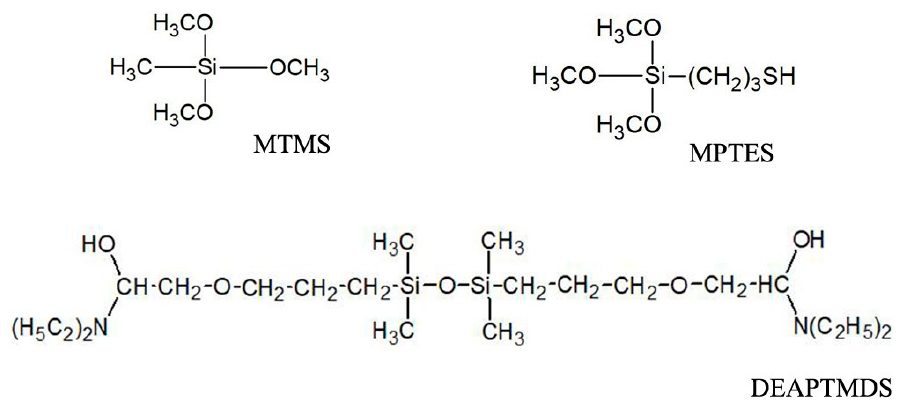
Figure 2. Chemical structure of organosilicons selected for the